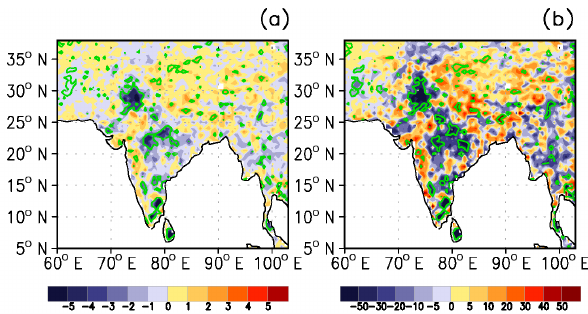
Figure 8. Difference (PLC–HLC) in JJAS-averaged 2m air temper- ature (in ◦ C; 1982–2008), for (a) daily mean, and (b) daily max- imum temperature. Green contour shows significance at the 90% confidence